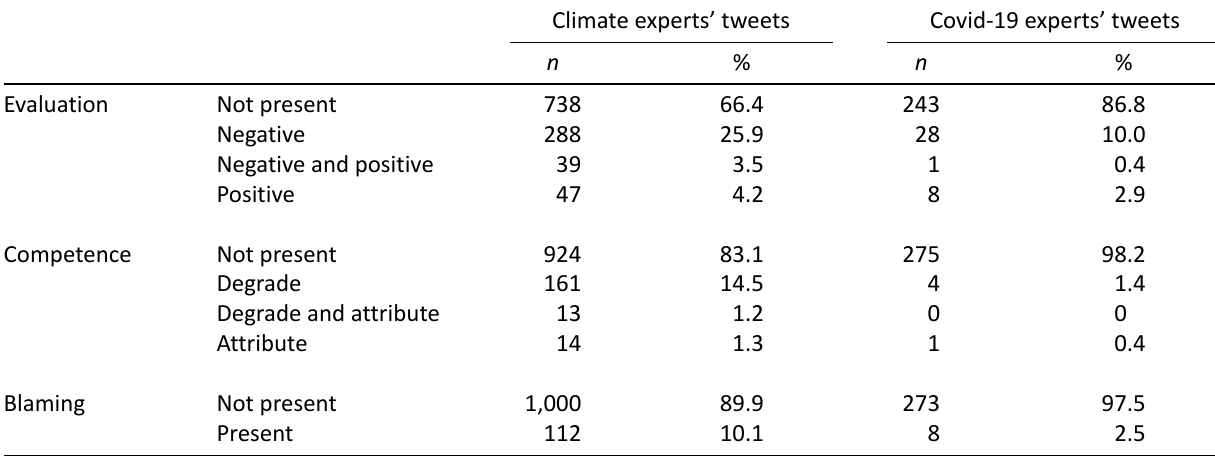
Table 3. Assessing behaviour in experts’ tweets addressing politics ( n =